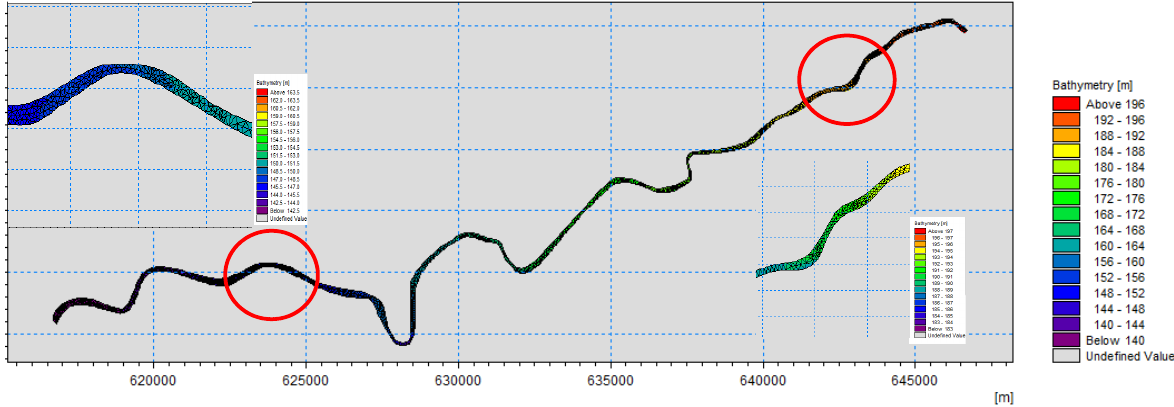
Figure 2. Mesh map.